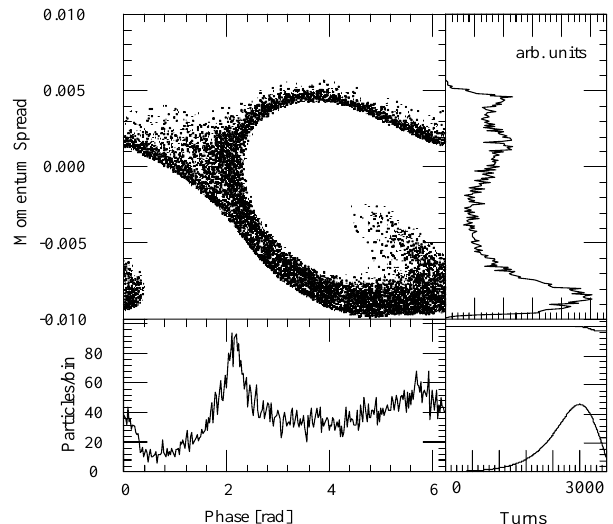
FIG. 1. The main window shows the longitudinal phase space after 3000 turns. The windows below and to the right show the longitudinal bunch distribution and the momentum distribution, respectively. The small window in the lower right-hand corner shows the survived fraction of particles (upper trace) and the bunching factor (lower trace) as a function of turn number. The vertical scale here extends from zero to